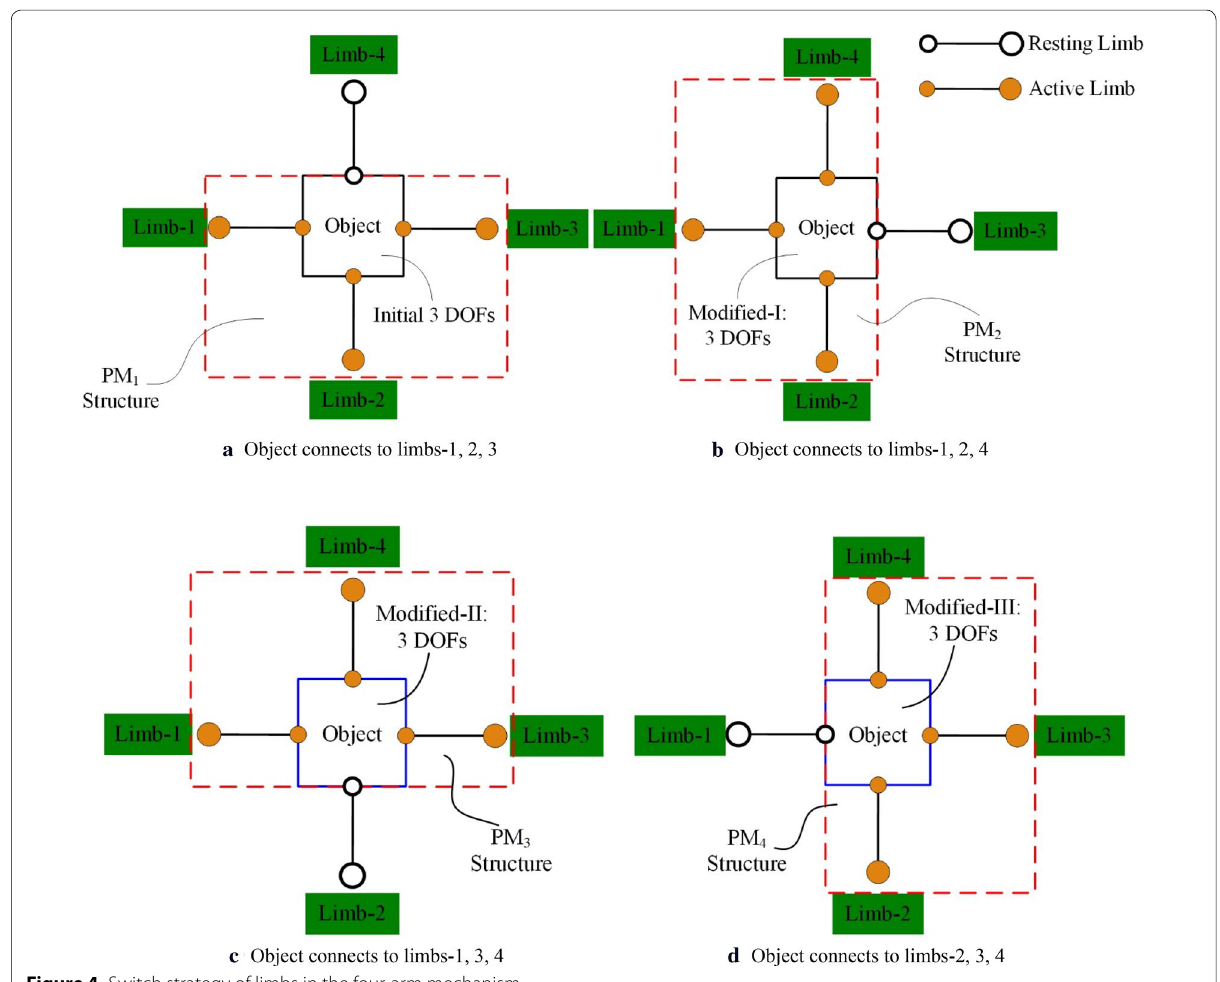
Figure 4 Switch strategy of limbs in the four‑arm